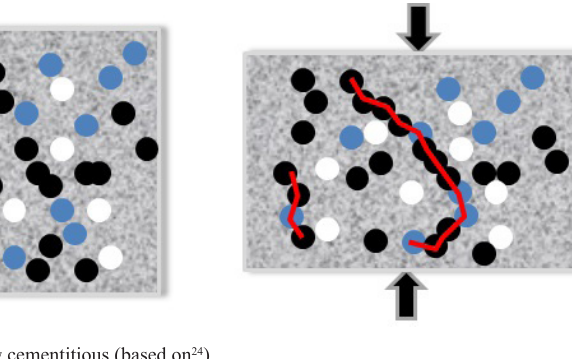
Figure 2. Conductive microstructure scheme in self-sensing cementitious (based on 24 ).